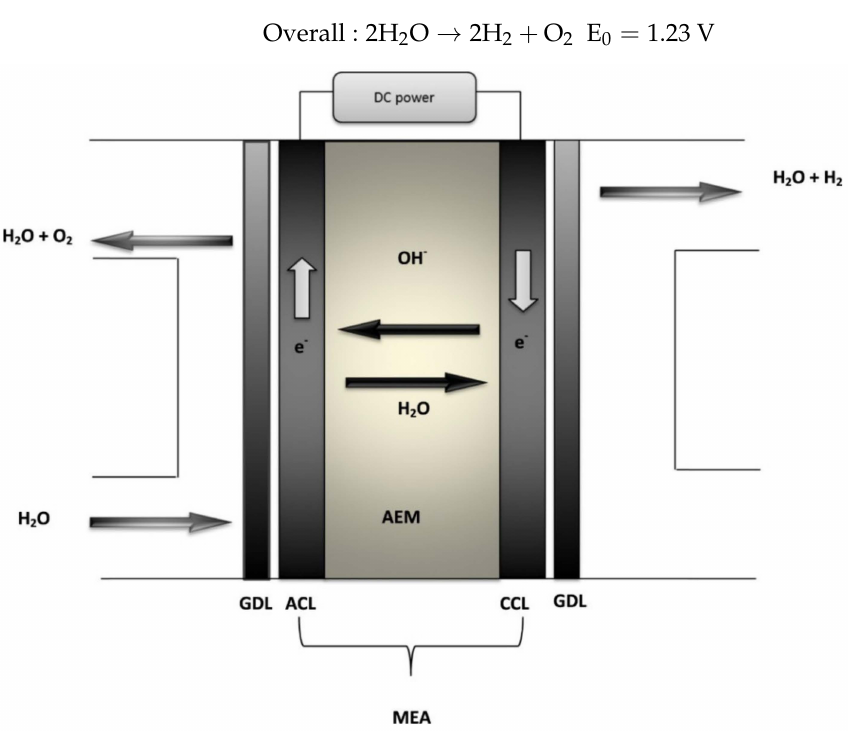
Figure 5. Diagram of an AEM water electrolysis. CCL: cathode catalyst layer, ACL: anode catalyst layer, GDL: gas diffusion layer, and MEA: membrane electrode assembly [56]. Reproduced with permission from Elsevier,